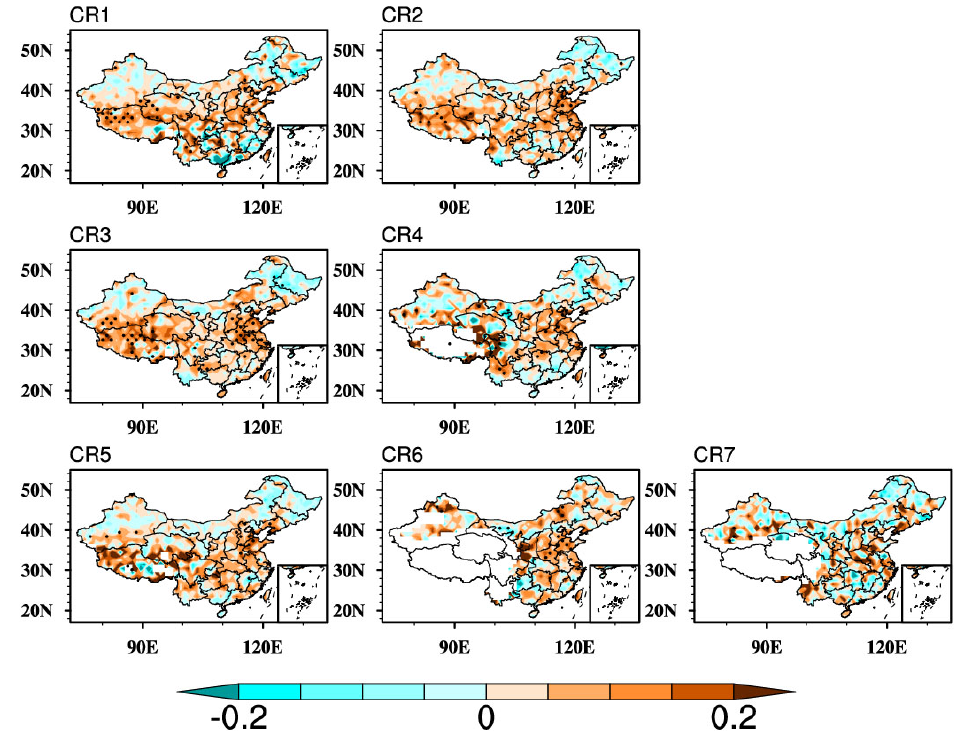
Figure 6. Same as Figure 5 but for correlation coefficient between COT and AOD.